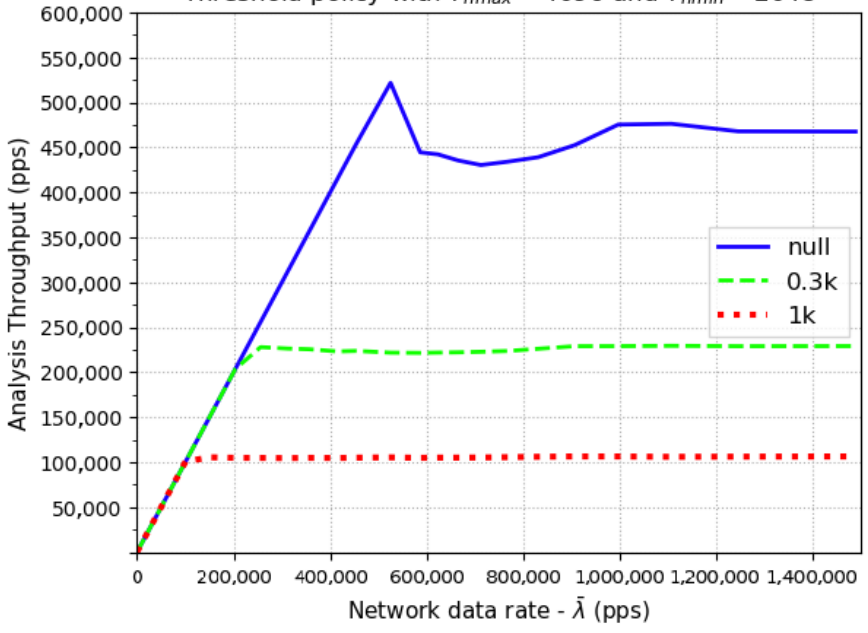
Figure 12. Performance of the real probe with the control mechanism.